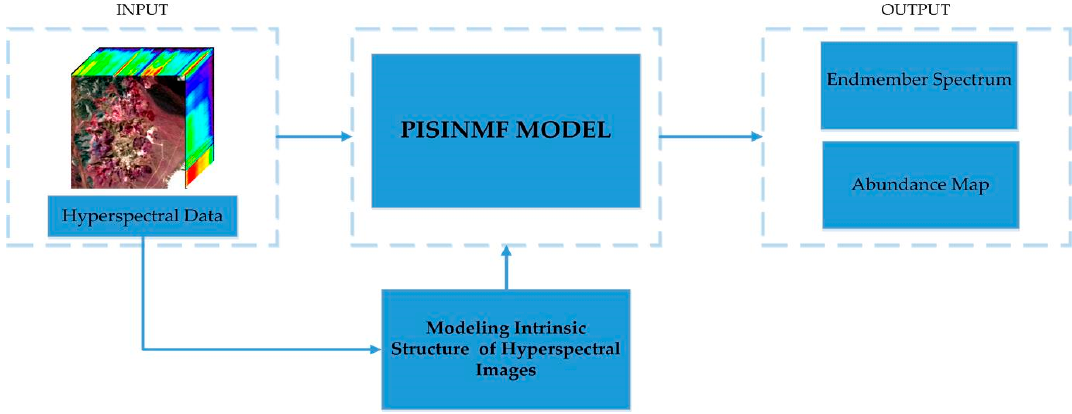
Figure 2. Schematic overview of the proposed method.